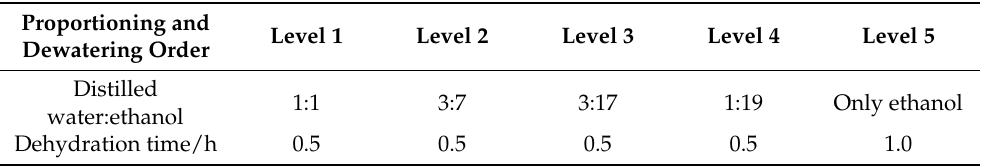
Table 1. The specific ratios of concentration grades used as dehydrating agents preceding preparation of paraffin sections of Bougainvillea